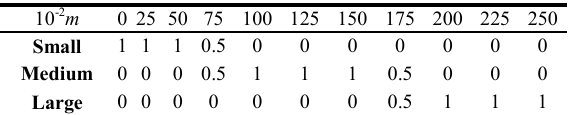
Table 3. Input membership discrete matrix of straight walking.